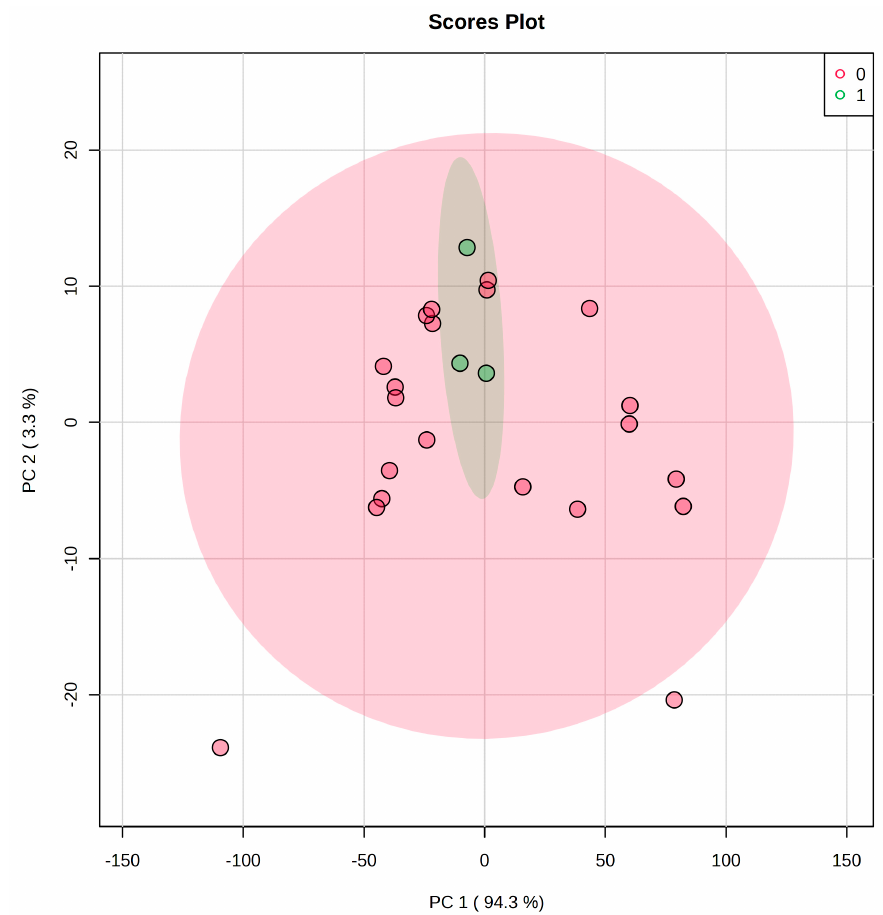
Figure 1. A PCA scores plot based on FTIR spectra obtained from two distilleries. Shaded areas are the 95% confidence